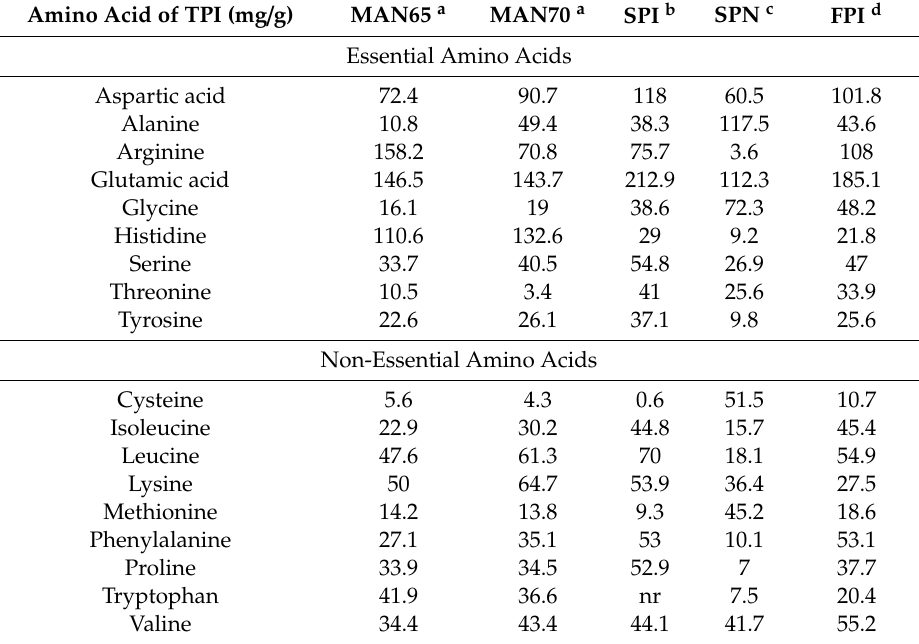
Table 3. Amino acid composition of thraustochytrid (MAN65 and MAN70) protein isolates. Amino Acid of TPI (mg /